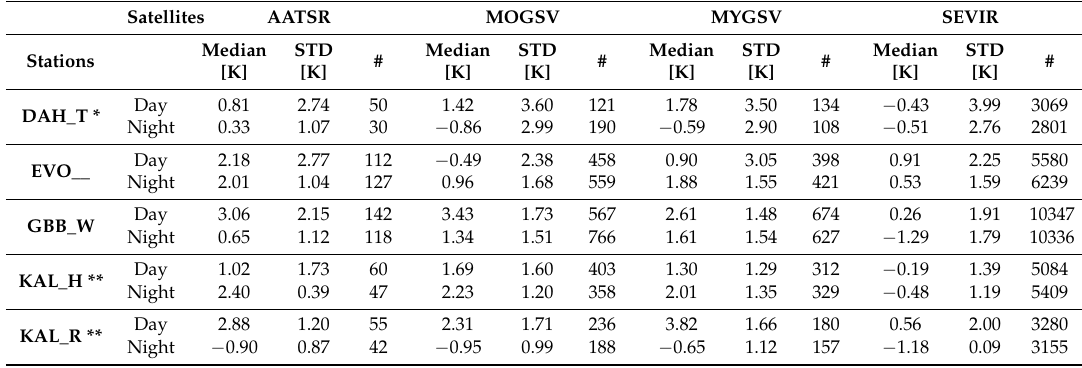
Table 4. Median validation accuracy, STD, and number of data points (#) over the KIT stations, for all satellites, and for the years 2010–2012.